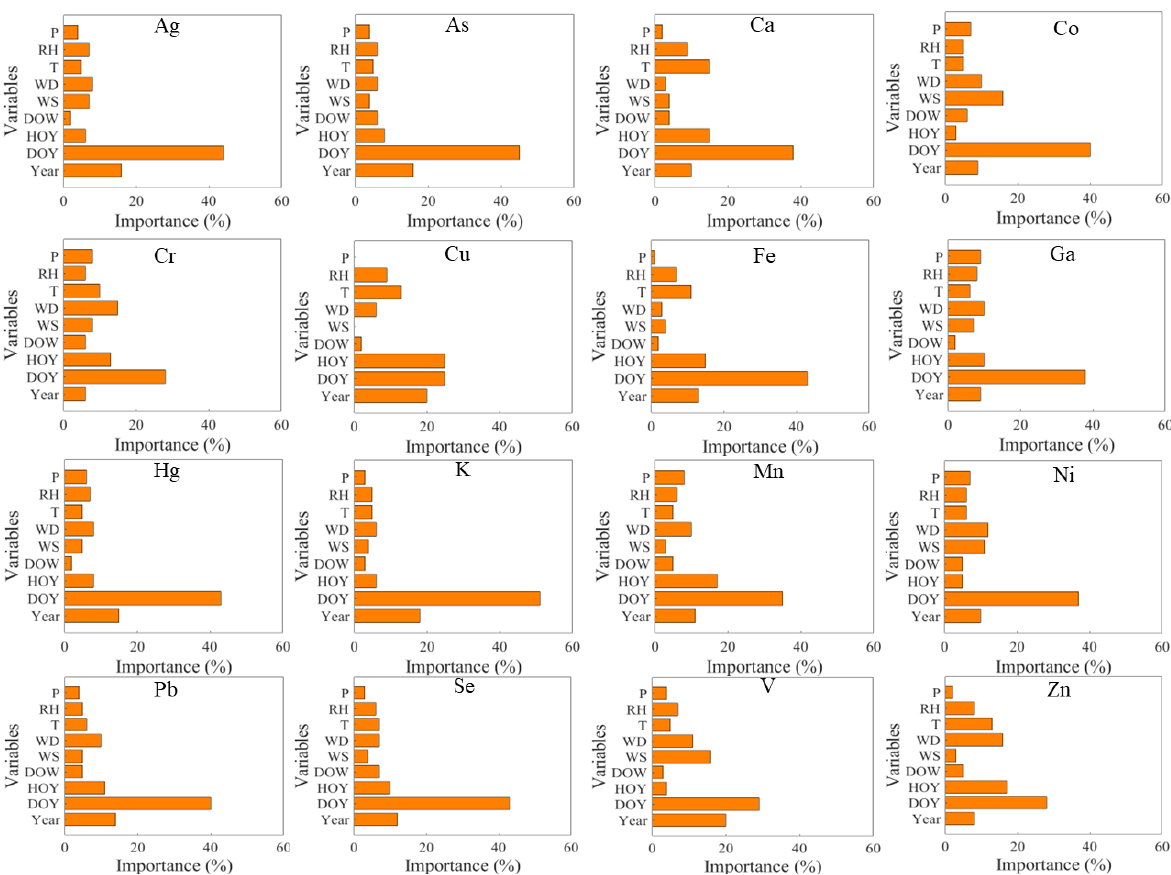
Figure 6. Relative importance of the predictors for the prediction of trace elements. The columns in the figure represent the variable impor- tance in the RF models for the trace elements. P , RH, T , WD, WS, DOW, HOY, DOY, and Year denote air pressure, relative humidity, air temperature, wind direction, wind speed, day of week, hour of day, day of year, and study year,